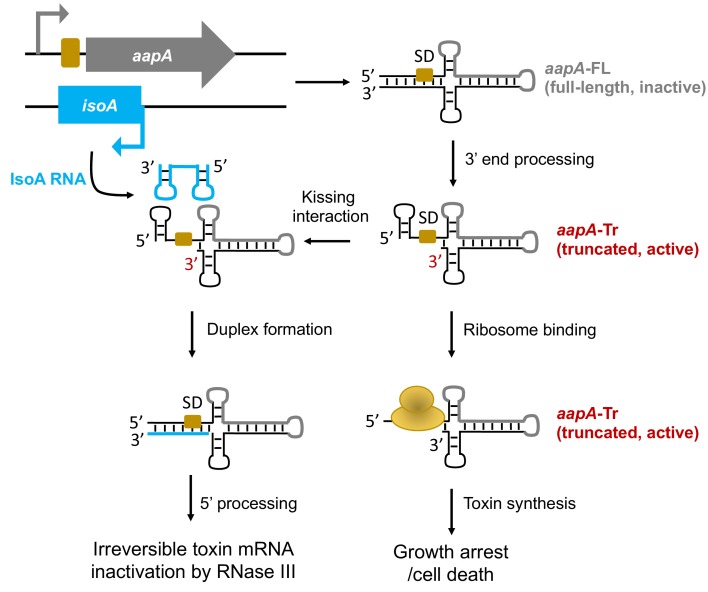
General model of the aapA/IsoA TA systems regulation in Helicobacter pylori.This model is based on experimental data described in our previous study (Arnion et al., 2017). The genetic organization of the aapA/IsoA modules is shown in the upper-left part of the figure. Bent arrows indicate promoters (gray and blue for aapA and IsoA, respectively). The aapA coding-sequence is represented by a thick gray line on the secondary structures. The Shine-Dalgarno (SD) sequence of aapA gene is symbolized by a yellow box. The IsoA sRNA antitoxin is shown in blue.